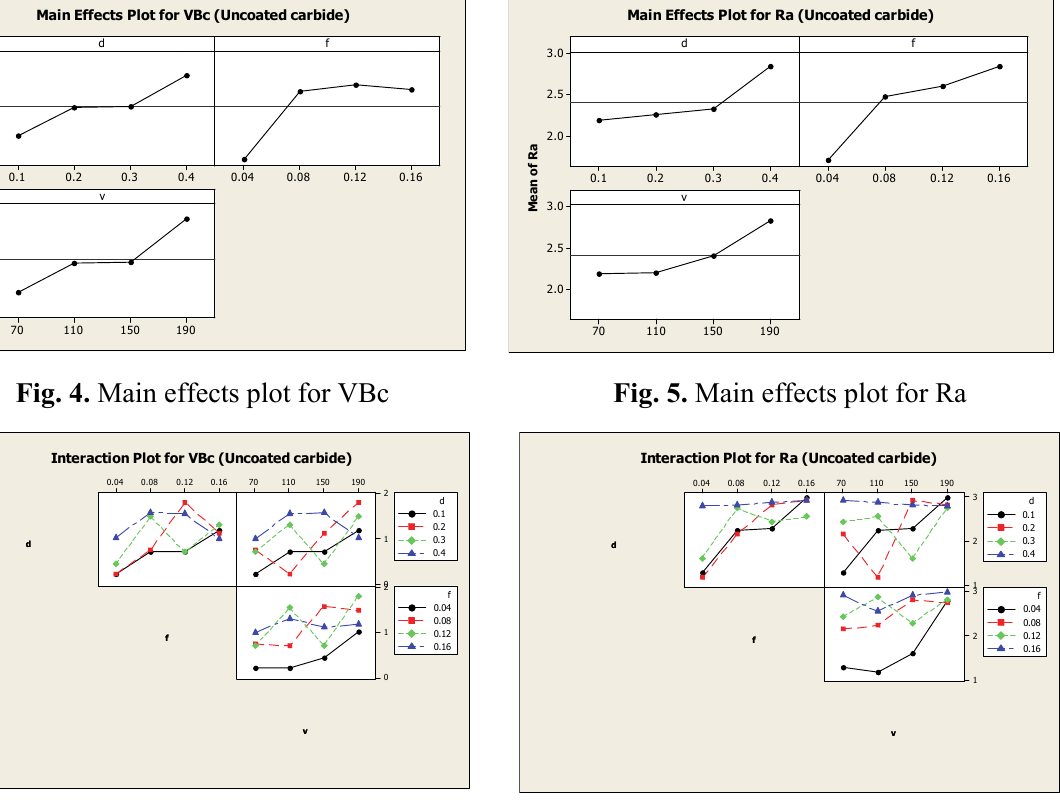
Fig. 6. Interaction plot for VBc Fig. 7. Interaction plot for